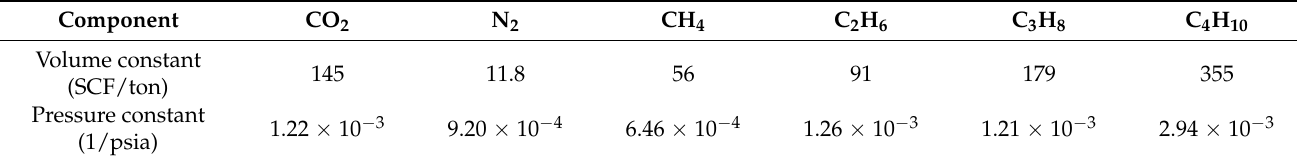
Table 3. Langmuir adsorption